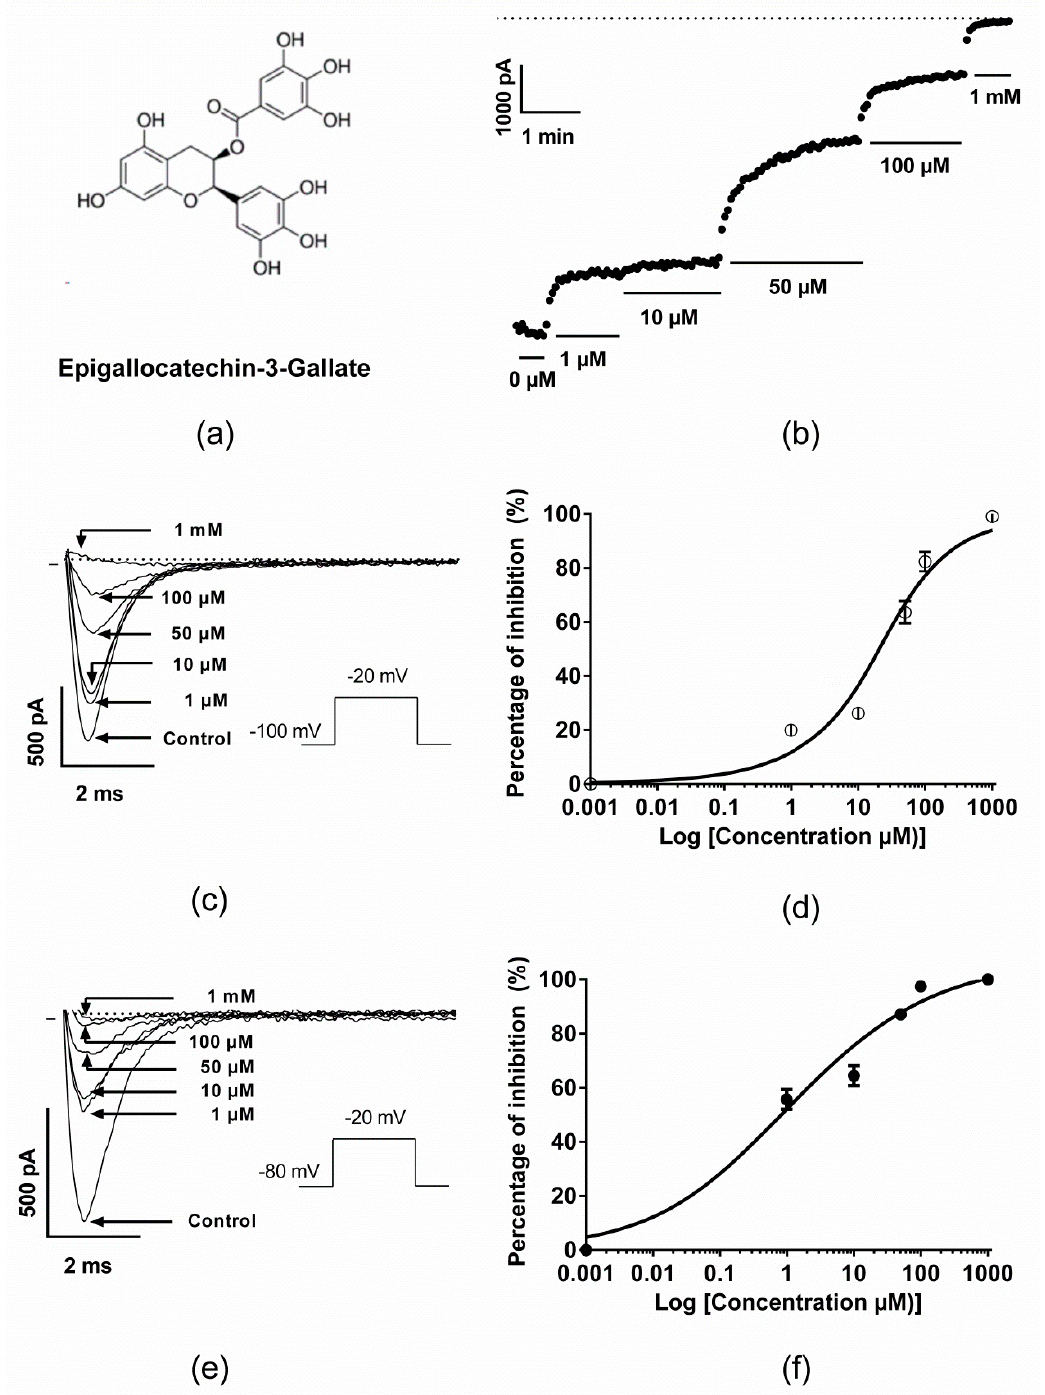
Figure 1. Pharmacological effects of Epigallocatechin-3-Gallate (EGCG) on the cardiac sodium channel Na v 1.5. ( a ) Chemical structure of EGCG. ( b ) Time course recording of the I Na current in the presence of various concentrations of EGCG. The dashed line represents the zero current. ( c ) Representative traces of I Na currents in the presence of various EGCG concentrations at holding potential − 100 mV. ( d ) Dose-response effects of EGCG on the inhibition of I Na peak currents (holding potential = − 100 mV, IC 50 = 31.2 ± 3.6 µM, n = 8). ( e ) Representative traces of I Na currents in the presence of various EGCG concentrations at holding potential − 80 mV. ( f ) Dose-response effects of EGCG on the inhibition of I Na peak currents (holding potential = − 80 mV, IC 50 = 2,1 ± 1 µM, n = 5–7).